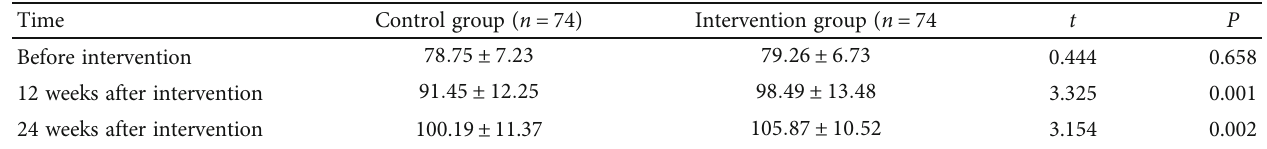
Table 2: Score of QLSCA between the two groups (point, (cid:1) x ± s ).